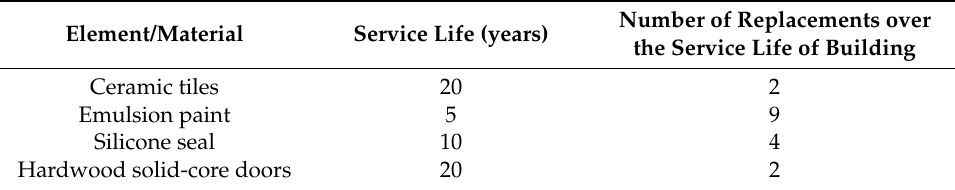
Table 3. Typical replacement of building elements during renovation in Hong